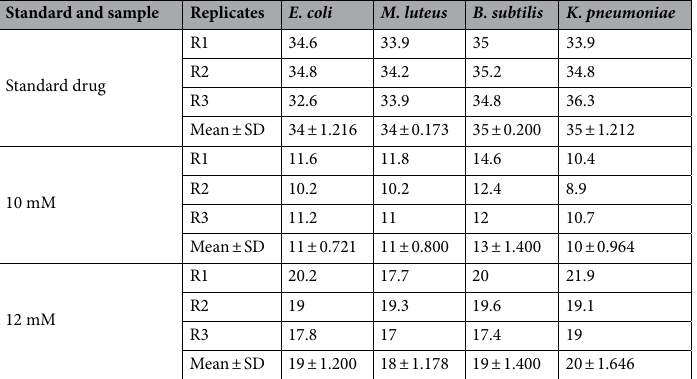
Standard and sample Replicates E. coli M.